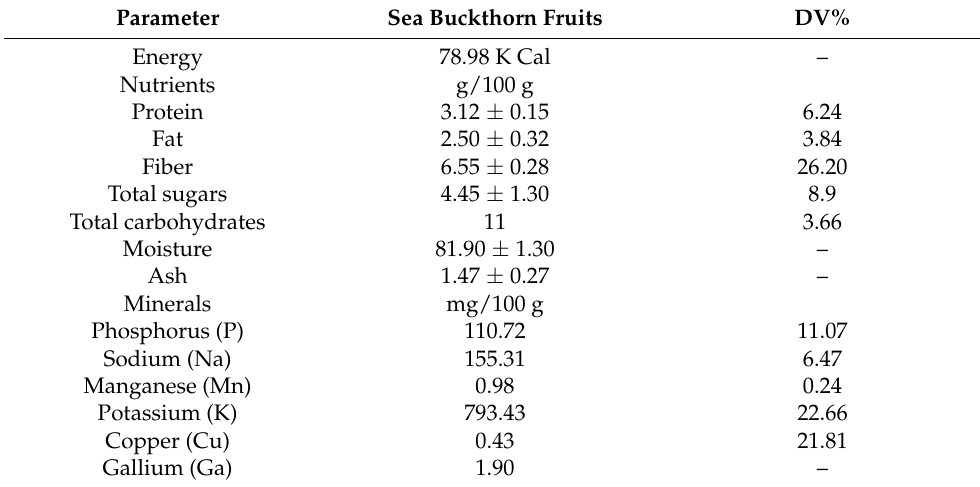
Table 1. Chemical composition and mineral content of sea buckthorn